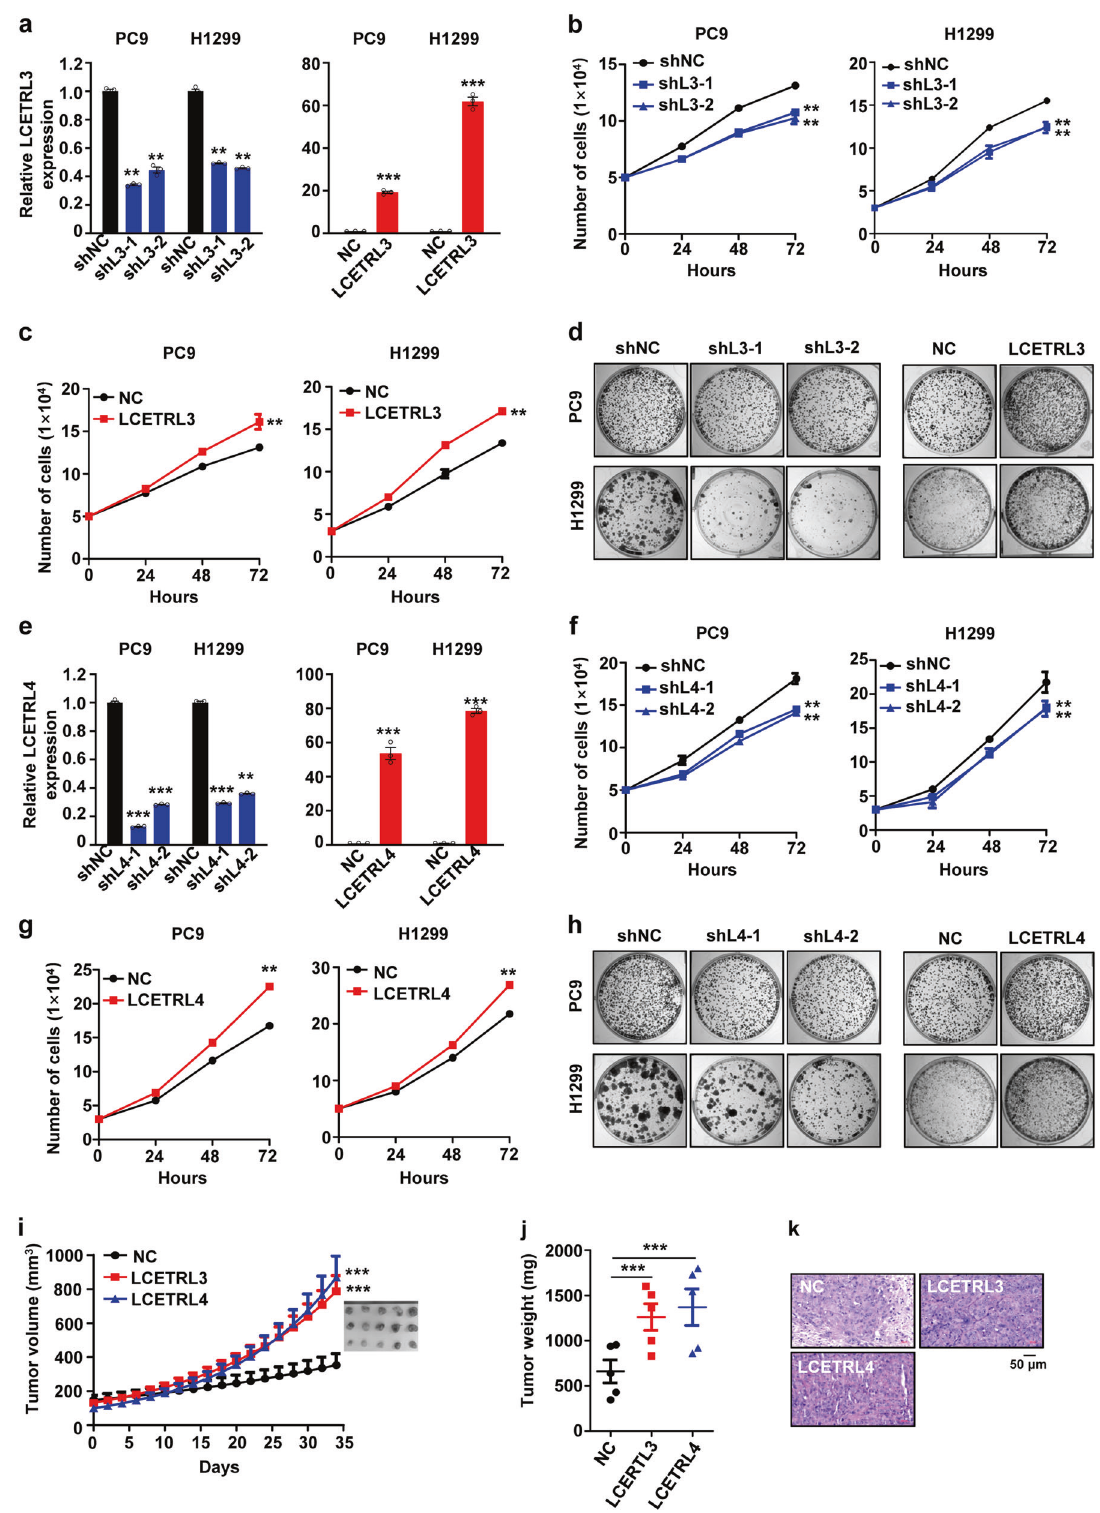
Fig. 2 LncRNAs LCETRL3 and LCETRL4 suppressed malignant proliferation of NSCLC cells in vitro and in vivo. ( a – c ) Silencing of LCETRL3 with shRNAs inhibited proliferation of PC9 and H1299 cells; whereas overexpressed lncRNA LCETRL3 promoted proliferation of NSCLC cells. (d) LCETRL3 promoted clonogenicity of PC9 and H1299 cells. ( e – g ) Knocking-down of lncRNA LCETRL4 with shRNAs inhibited proliferation of PC9 and H1299 cells. On the contrary, overexpression of LCETRL4 promoted viability of NSCLC cells. ( h ) LCETRL4 stimulated colony formation of PC9 and H1299 cells. ( i – k ) In vivo growth of NSCLC xenografts was promoted by lncRNA LCETRL3 or LCETRL4. Two-tailed unpaired t test, ** P < 0.01, *** P < 0.001